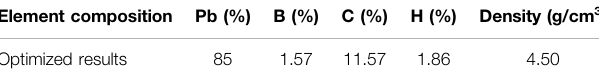
TABLE 1 | Optimization design results of the element composition ratio of the lead – boron polyethylene shielding composite (mass